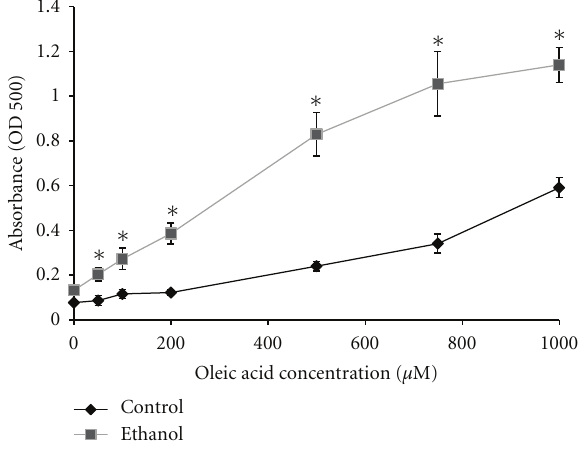
Figure 2: Oil Red O-based quantification of ethanol and oleic acid-induced fat accumulation in hepatoma hybrid cells. WIF-B c ells were treated for 48 hr with or without 25 mM ethanol in presence of di ff erent concentrations of oleic acid and lipid content quantified with Oil Red staining. Values are means ± SEM ( N = 4). ∗ Significantly di ff erent ( P < 0 . 05) from control